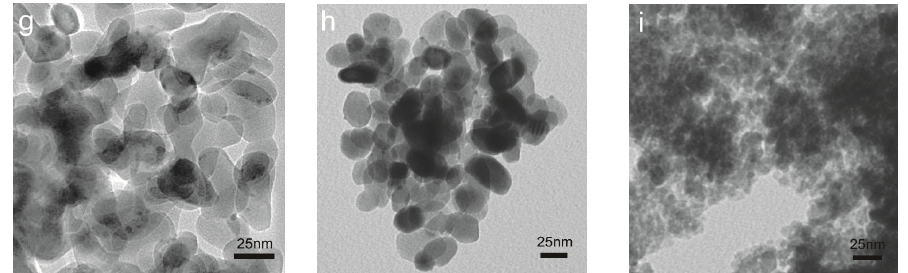
Figure 3. TEM images of used Au/FeO x catalysts: ( a ) Au/Fe_OH_11.2; ( b ) Au/Fe_OH_9.7; ( c ) Au/Fe_OH_8.2; ( d ) Au/Fe_OH_6.7; ( e ) Au/Fe_O_600; ( f ) Au/Fe_O_500; ( g ) Au/Fe_O_400; ( h ) Au/Fe_O_300; and ( i ) Au/Fe_O_200.